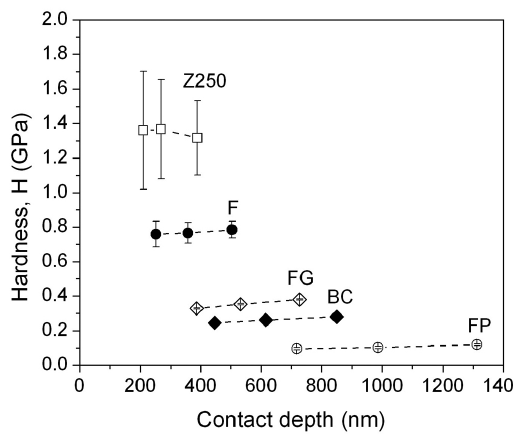
Figure 3. Hardness (H) values obtained from nanoindentation tests as a function of contact depth for the following samples: bare Filtek Z250 ® composite resin (Z250), and Z250 samples filled with Fortify Plus ® (FP), Fortify ® (F), FillGlaze ® (FG) and BisCover ® (BC) sealants. Dashed lines are guides to the eyes.